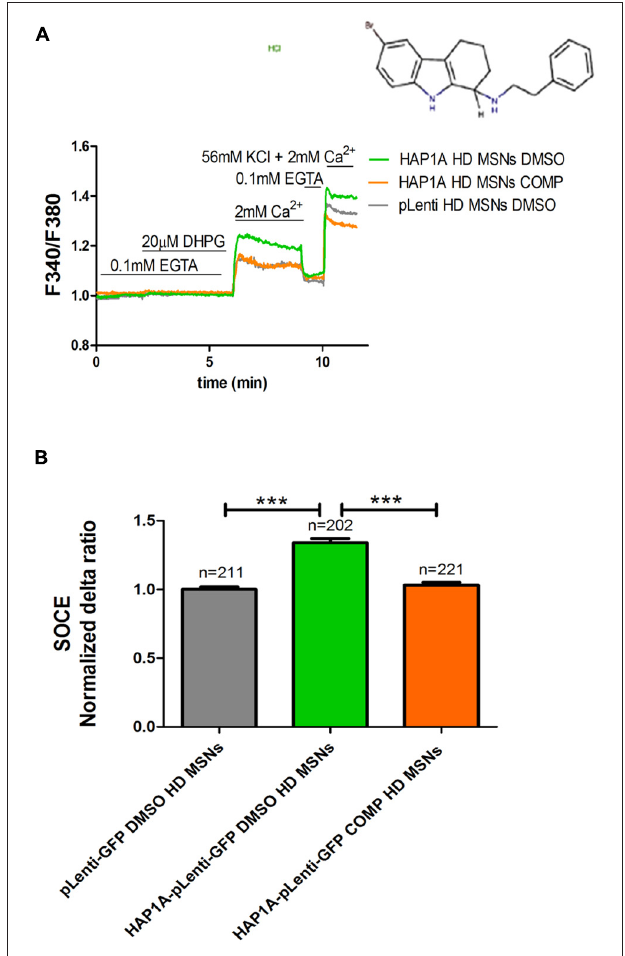
FIGURE 5 | Effect of tetrahydrocarbazole on Ca 2 + signals in MSNs that overexpress HAP1A. MSN cultures on DIV14 from YAC128 mice that overexpressed HAP1A-pLenti-GFP or pLenti-GFP as a control were loaded with the Ca 2 + indicator Fura-2AM and incubated in Ca 2 + -free medium. The MSN cultures were incubated for 5 min with tetrahydrocarbazole or dimethylsulfoxide (DMSO; control) in Ca 2 + -free medium. (A) The figure shows the protocol to measure DHPG-induced SOCE using the eight-well system. The structural formula of 6-bromo- N -(2-phenylethyl)-2,3,4,9-tetrahydro-1 H - carbazol-1-amine hydrochloride is shown. The effect of tetrahydrocarbazole on DHPG-induced SOCE in YAC128 MSNs that overexpressed HAP1A-pLenti-GFP was measured followed by the re-addition of 2 mM Ca 2 + to the medium compared with YAC128 MSNs that overexpressed HAP1A-pLenti-GFP or pLenti-GFP and were treated with 0.02% DMSO as a control. KCl (56 nM) in 2 mM Ca 2 + was applied to distinguish neurons from glial cells at the end of the protocol. (B) Ca 2 + influx via DHPG-induced SOCE in YAC128 MSNs overexpressed HAP1A-pLenti-GFP isoform and were treated with tetrahydrocarbazole compared with YAC128 MSNs that overexpressed HAP1A-pLenti-GFP or pLenti-GFP that were treated with 0.02% DMSO. The results are expressed as mean ± SEM. The number of cells is shown on the top of the bars. ∗∗∗ p < 0.001. The results were obtained from three independent MSN culture